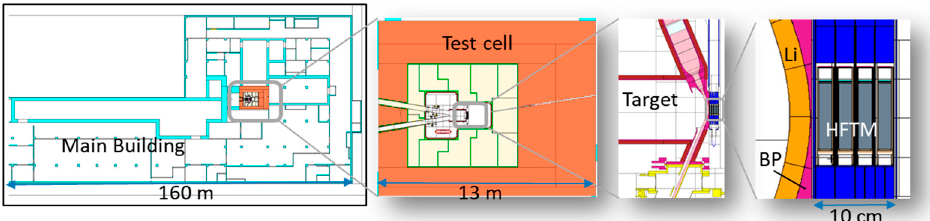
Figure 2. Neutronic geometries of the IFMIF-DONES building and the test cell in horizontal cut-view, and target assembly, HFTM, and BP in vertical cut-view.